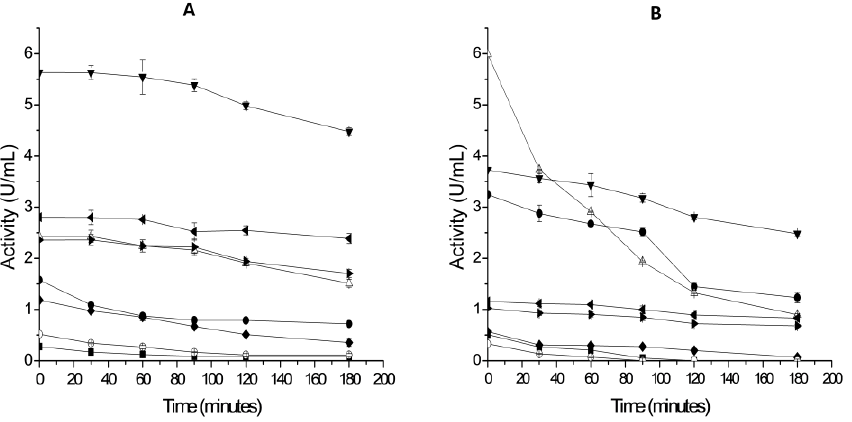
Figure 4. pH stability of pure lipases ( A ) Lip1 ( B ) Lip2. pH symbols: - ■ - 3.0; -●- 4.0; - - 5.0; - ▼ - 6.0; - ◄ - 7.0; - ► - 8.0; - - 9.0; - ○ - 10.0.